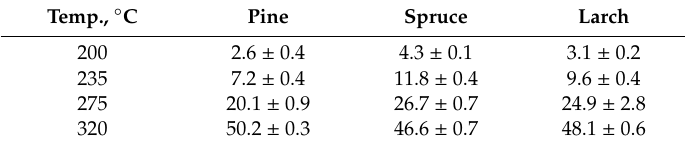
Table 2. Sample weight loss (%) depending on torrefaction